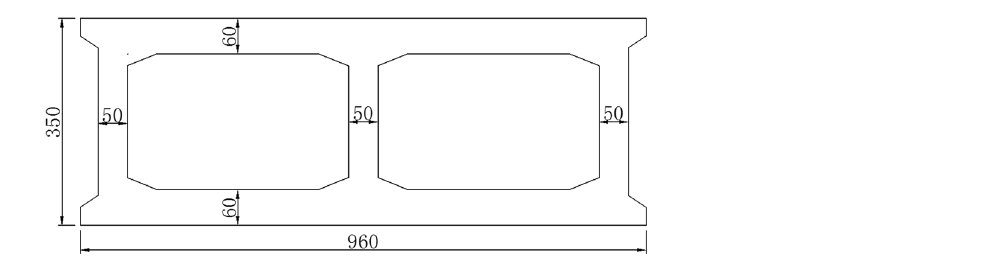
Figure 3. The overall drawing of Jiming Sansheng Bridge (unit: cm).